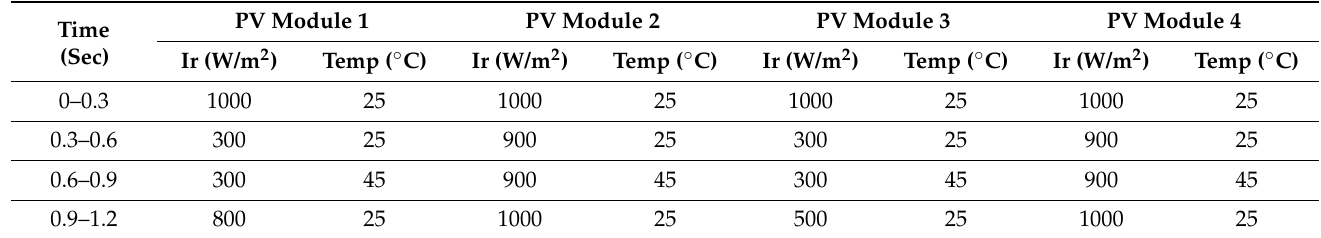
Table 4. Varying irradiance and temperature with